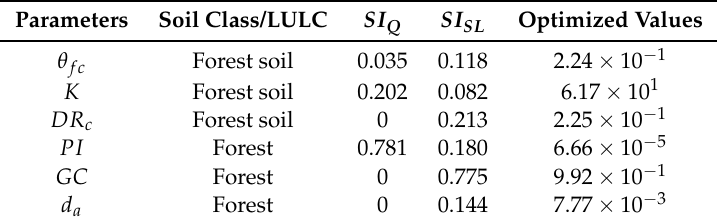
Table 5. List of important parameters from forested site with Sobol’ index greater than 0.05 for stream discharge ( SI Q ) and suspended sediment to the stream ( SI SL ), and their optimized values from the DE algorithm.